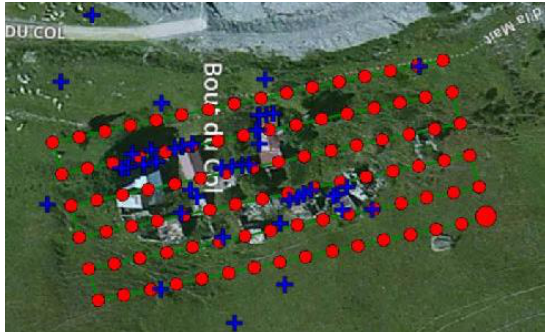
Figure 9. Flight plan (green lines), camera positions (red dots) and measured GCPs (blue crosses) - Zenmuse XT2 thermal acquisition.